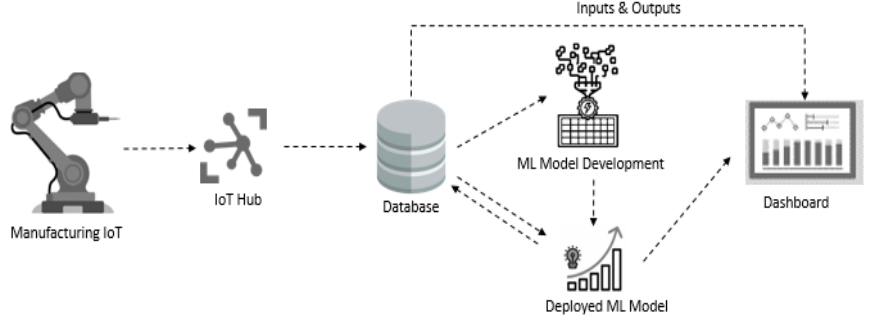
Figure 2. Expulsion prediction architecture.